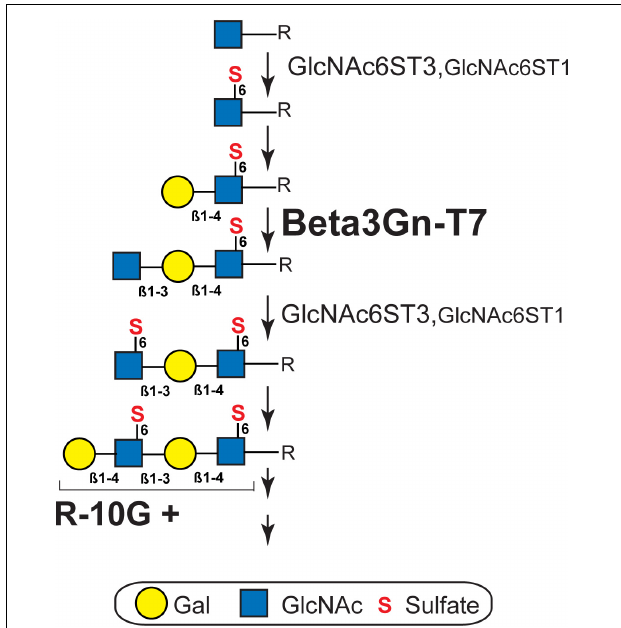
FIGURE 3 | Biosynthesis pathway of brain keratan sulfate. R-10G-positive (R-10G +) brain keratan sulfate (KS) is extended from the variable underlying the core glycans (R). The sequence of biosynthesis is C-6 sulfation (S) of N -acetylglucosamine (GlcNAc) residue exposed at the non-reducing terminal by GlcNAc6ST3 or GlcNAc6ST1 (Narentuya et al., 2019), transfer of galactose (Gal) by a β 1,4-galactosyltransferase, and then the transfer of GlcNAc by β 1,3 N -acetylglucosaminyltransferase 7 (Beta3Gn-T7; shown in this study). GlcNAc6ST3 is a major KS GlcNAc6ST in the adult brain (Narentuya et al., 2019) and its contribution to KS synthesis in the developing brain is partially complemented by GlcNAc6ST1 (Takeda-Uchimura et al., 2015). β 1,4-galactosyltransferase for KS synthesis in adult brains has not yet been identified. The KS structure extending from the R-10G + epitope can be additionally sulfated at some Gal residues by KSGal6ST (Hoshino et al., 2014). The length and degree of sulfation of cerebral KS vary during brain development, maturation, and